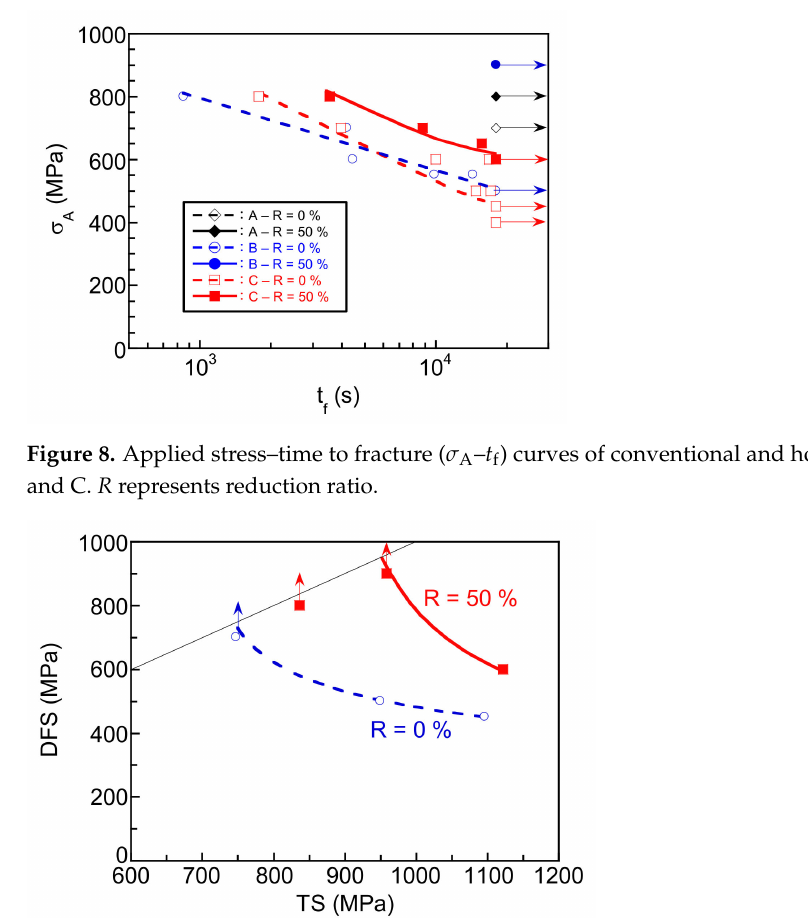
Figure 9. Relationship between delayed fracture strength ( DFS ) and tensile strength ( TS ) of conven- tional and hot-forged steels A, B, and C. R represents reduction